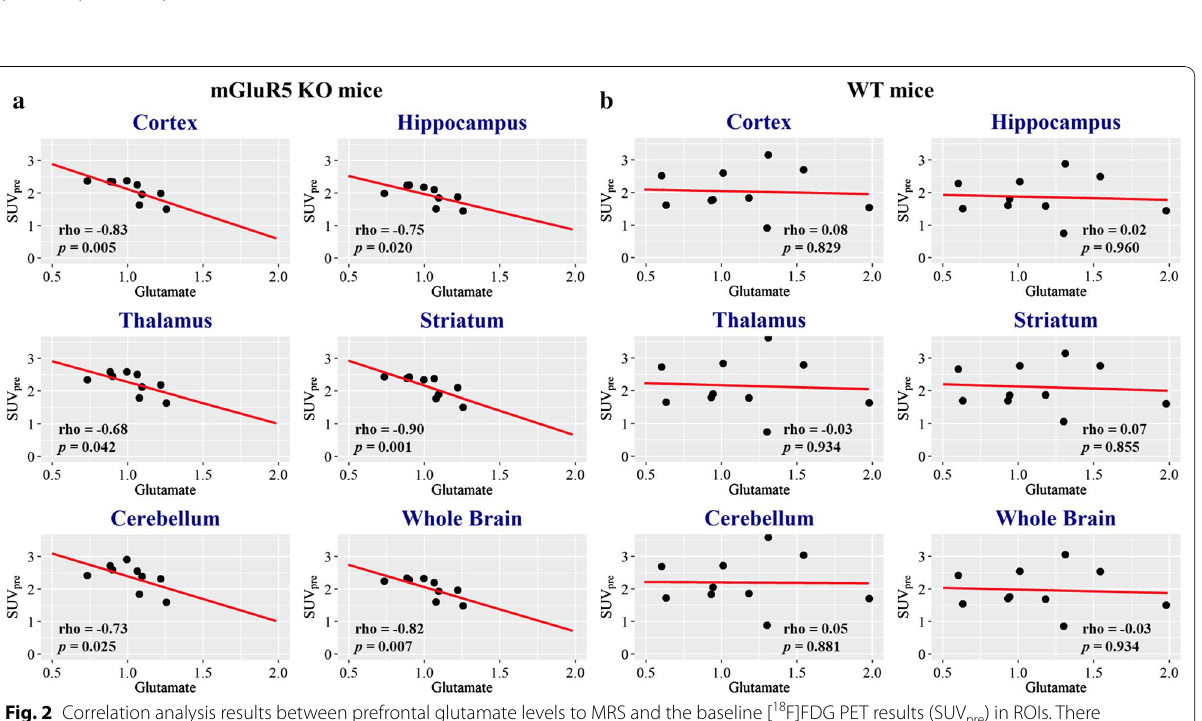
2.30 p 0.022), striatum ( z 2.77 = − = = −